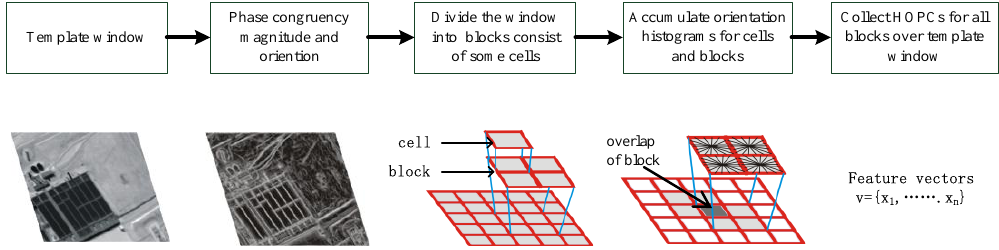
Figure 6. The main processing chain of the HOPC